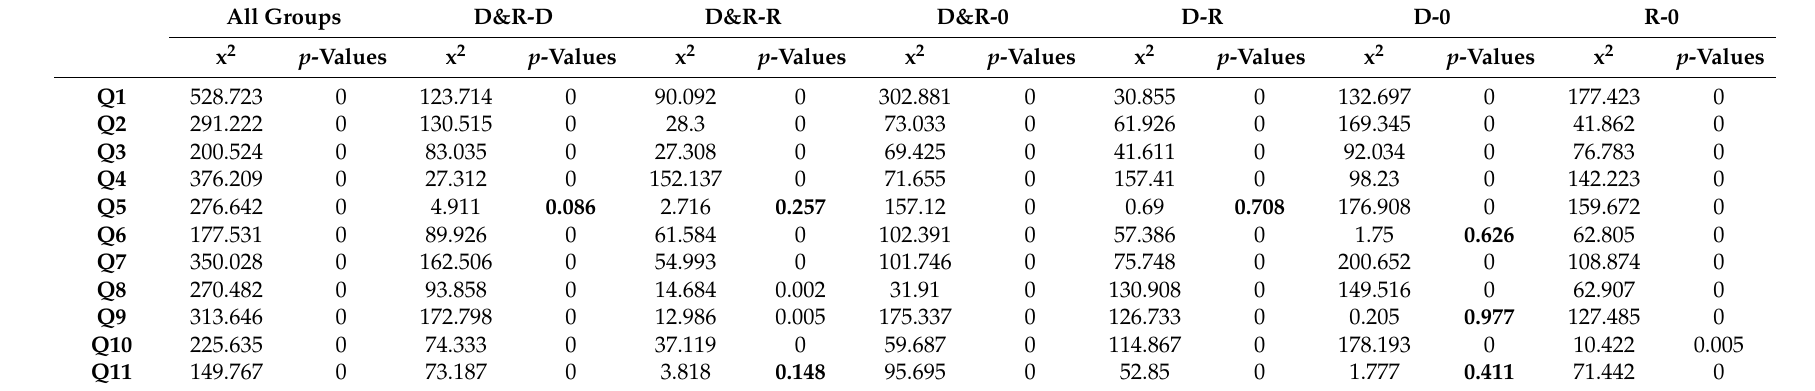
Table 2. Chi-squared test of independence (bold values indicate that the test is not significant).